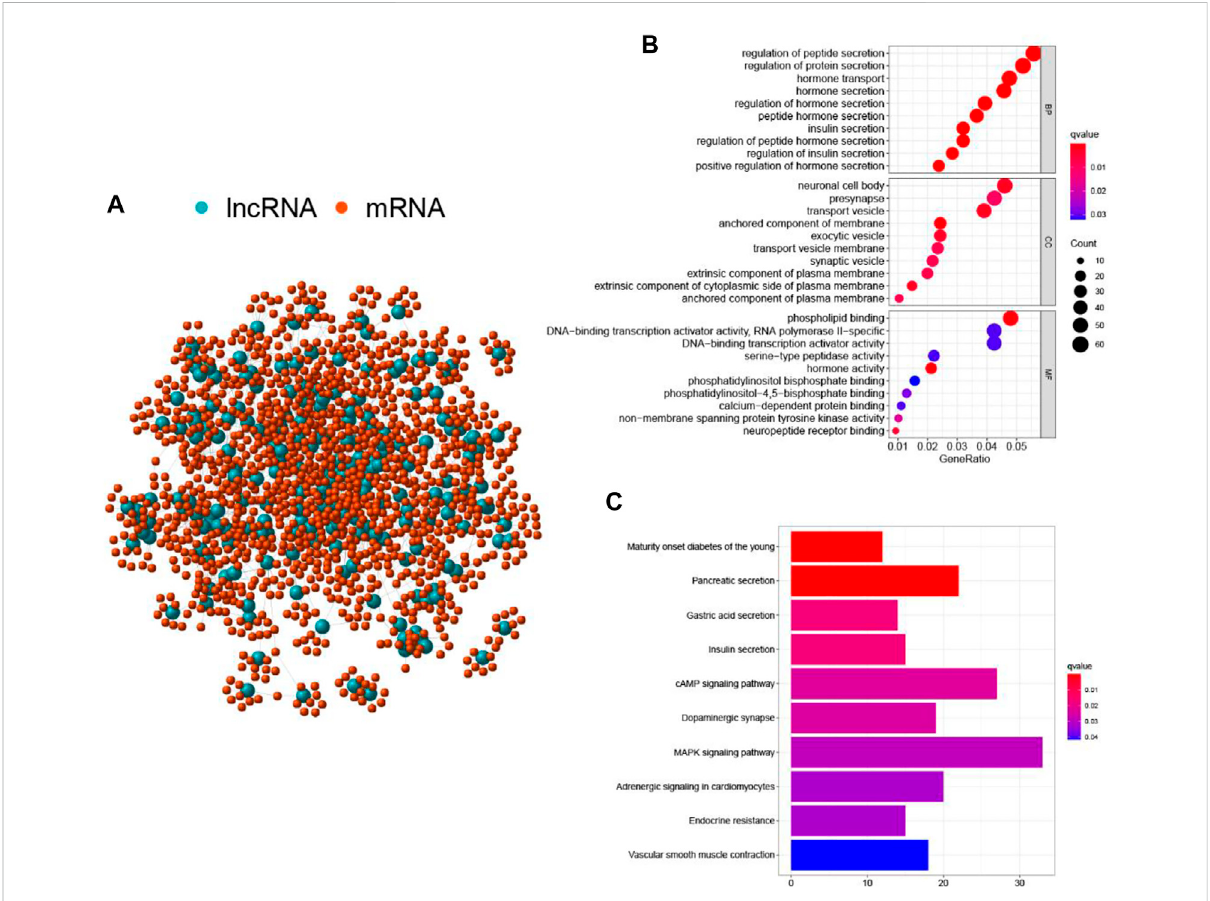
FIGURE 3 Functional annotations of GILnc in patients with pancreatic cancer. (A) Co-expression network of GILnc and mRNAs. The blue and red circles represented the LncRNAs and protein-coding mRNAs, respectively. Functional enrichment analysis of GO biological process (B) and KEGG pathway (C) for the co-expressed protein genes with